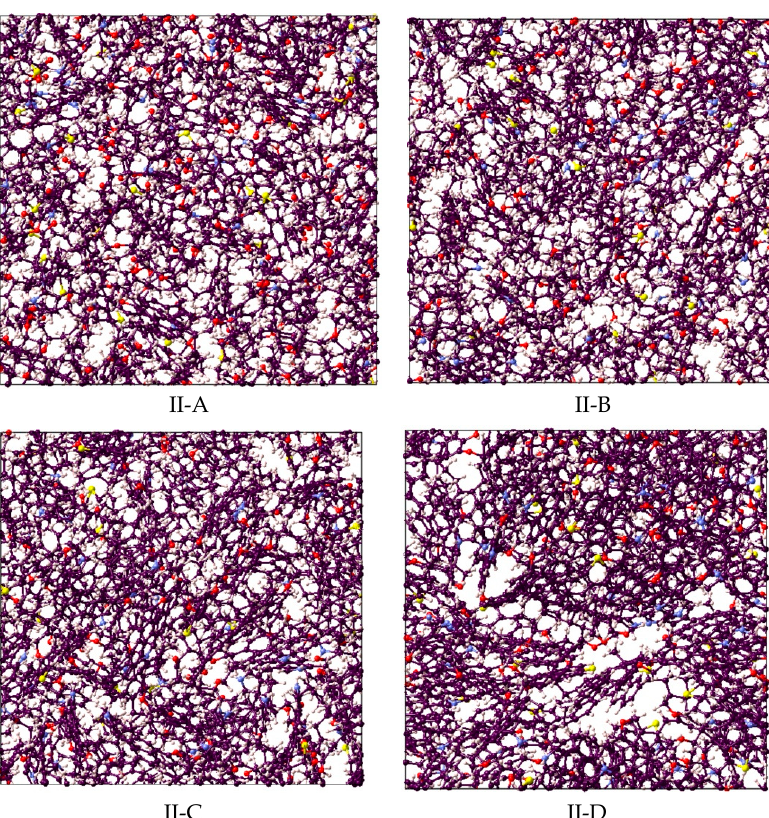
Figure 7. Final kerogen structure comprised of carbon (black), oxygen (red), sulfur (yellow), nitrogen (blue), and hydrogen (gray).